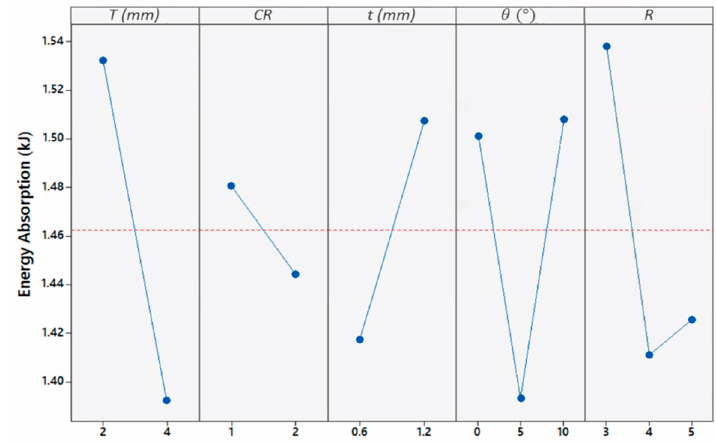
Figure 18. Dependence of (cid:2013) (cid:3046)(cid:3047)(cid:3045)(cid:3042)(cid:3038)(cid:3032) on the interaction of top-plate and tube thicknesses.